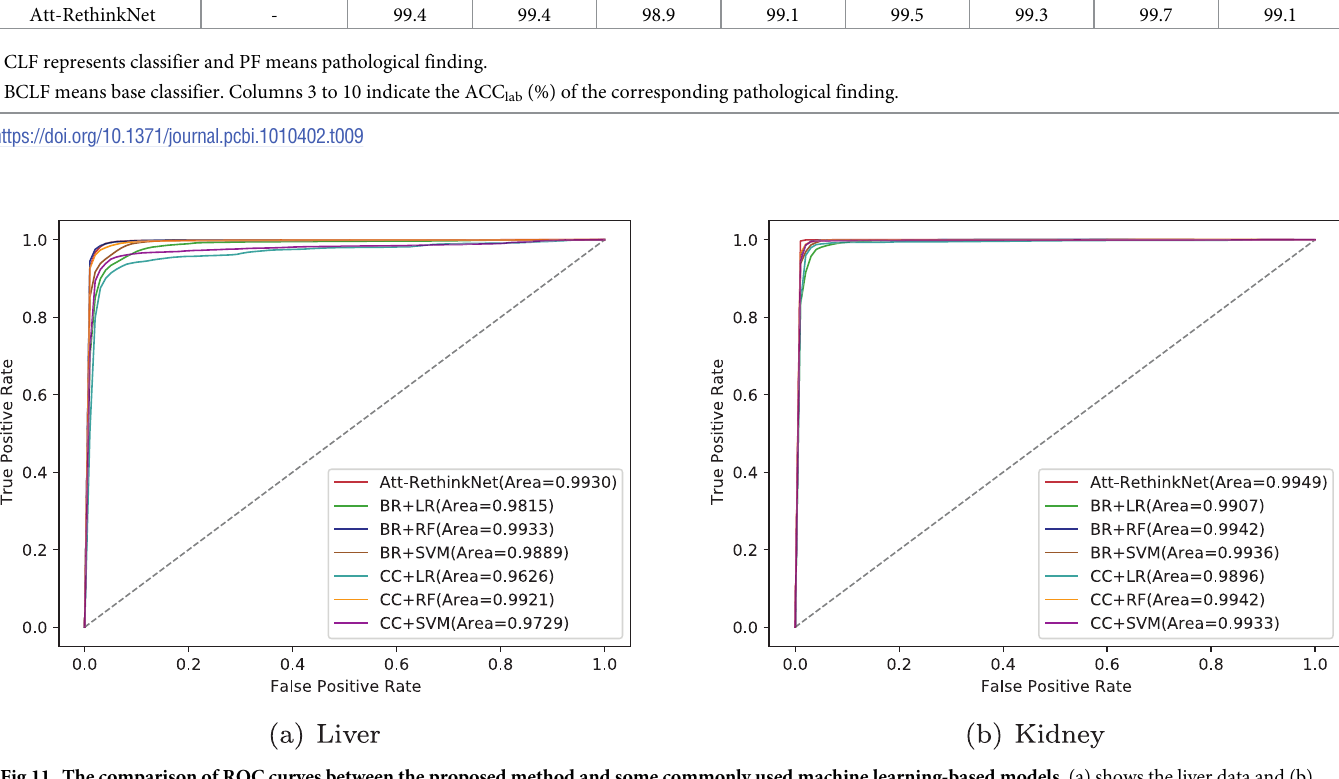
Fig 11. The comparison of ROC curves between the proposed method and some commonly used machine learning-based models. (a) shows the liver data and (b) shows the kidney data. In the plot, BR plus LR represents BR model that uses LR as base classifier. Other symbols are defined similarly.